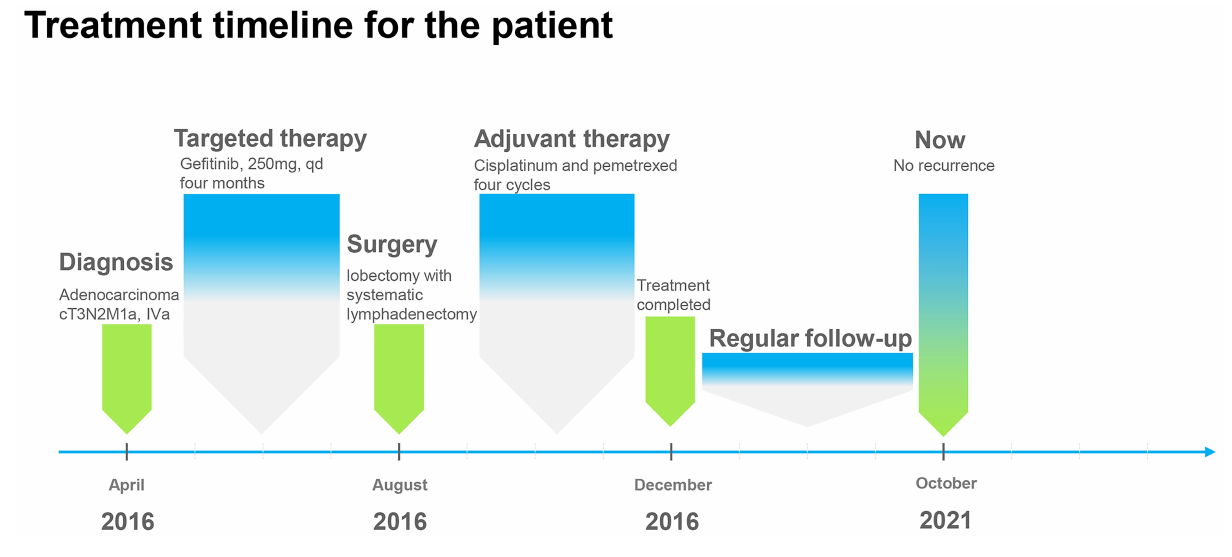
Frontiers in Surgery |